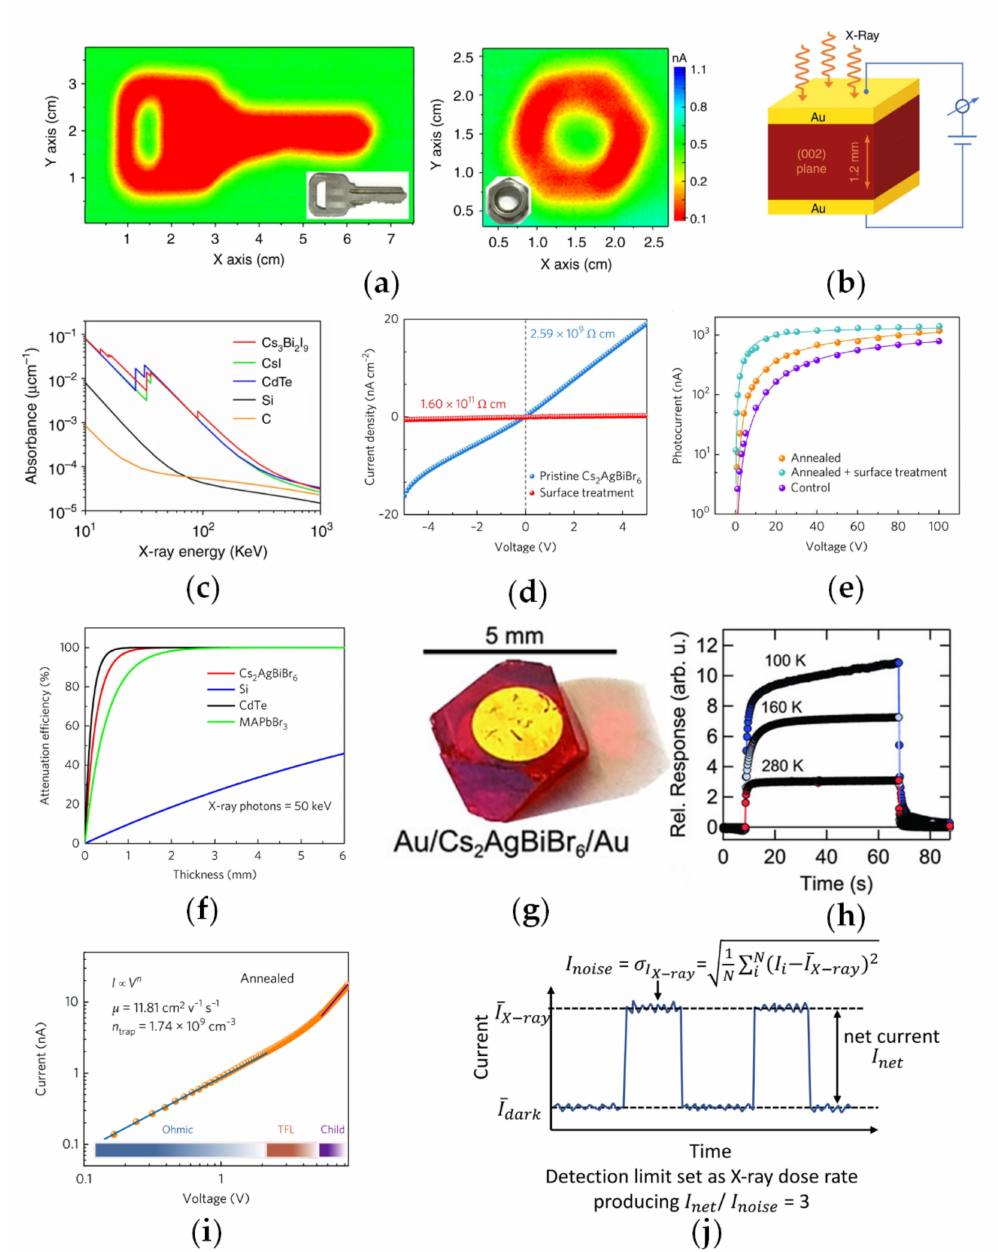
Figure 8. ( a ) X-ray image of key and nut obtained from the Cs 3 Bi 2 I 9 PSC detector. Adapted with permission from Ref. [90]. 2020, Springer Nature; ( b ) schematic of the Cs 3 Bi 2 I 9 PSC-based X-ray detector structure. Adapted with permission from Ref. [90]. 2020, Springer Nature; ( c ) absorption coefficients of Cs 3 Bi 2 I 9 and other materials. Adapted with permission from Ref. [90]. 2020, Springer Nature; ( d , e ) comparative measurements of resistivity and responsivity of devices made of the pristine crystal and treated crystal. Adapted with permission from Ref. [114]. 2017, Springer Nature; ( f ) relationship between attenuation efficiency and thickness of 50 keV X-ray photons in several typical semiconductors. Adapted with permission from Ref. [114]. 2017, Springer Nature; ( g ) photograph of fabricated detectors based on Cs 2 AgBiBr 6 PSC. Adapted with permission from Ref. [133]. 2018, John Wiley and Sons; ( h ) measurement results of photocurrent response of the detector to 61.12 µ Gy S − 1 X-ray at different temperatures. Adapted with permission from Ref. [133]. 2018, John Wiley and Sons; ( i ) measurement results of I − V test with the corresponding schematic diagram of different stages. Adapted with permission from Ref. [114]. 2017, Springer Nature; ( j ) diagram explanation of detection limit. Adapted with permission from Ref. [123]. 2021, Springer